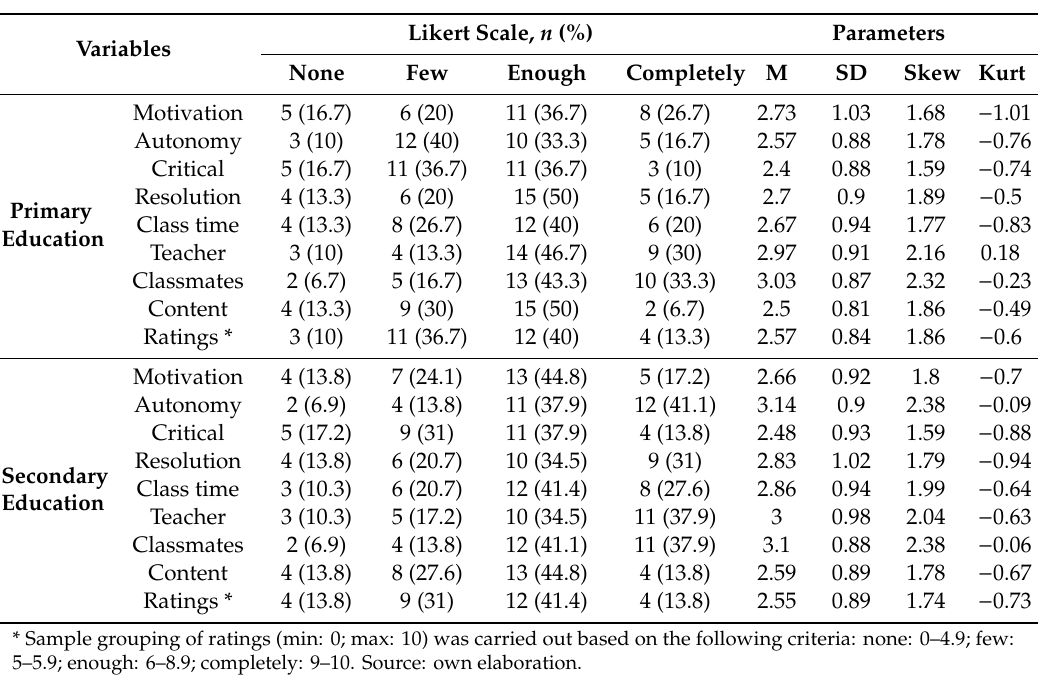
Table 5. Results obtained for study variables in experimental group.